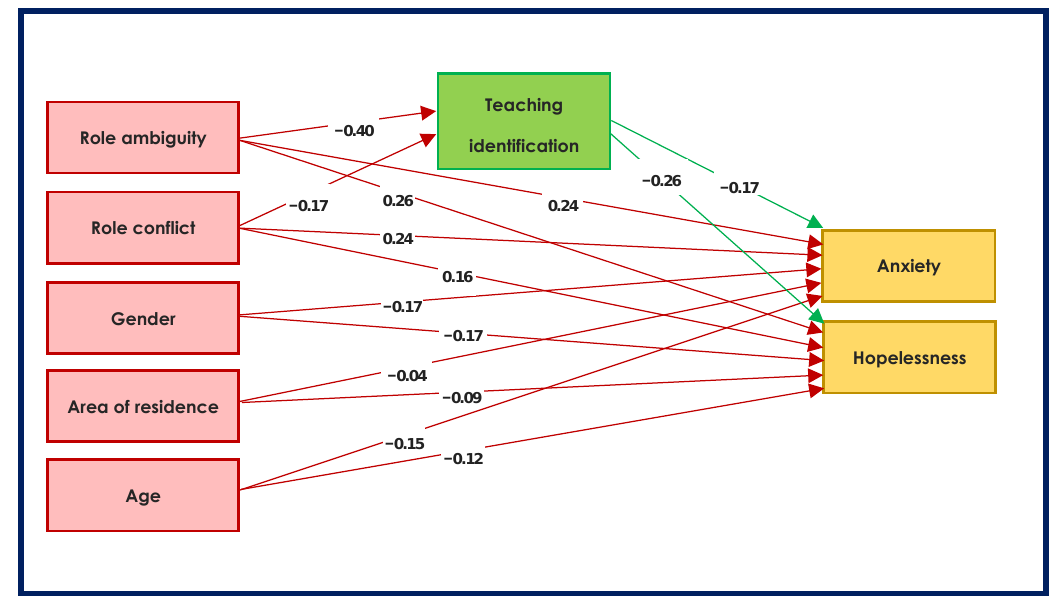
Figure 1. Structural equation model of the relationship between role stress, teaching identification and psychological distress. Note. Regression weights are standardized. All paths involving independent variables, mediators and dependent variables are significant p < 0.01.